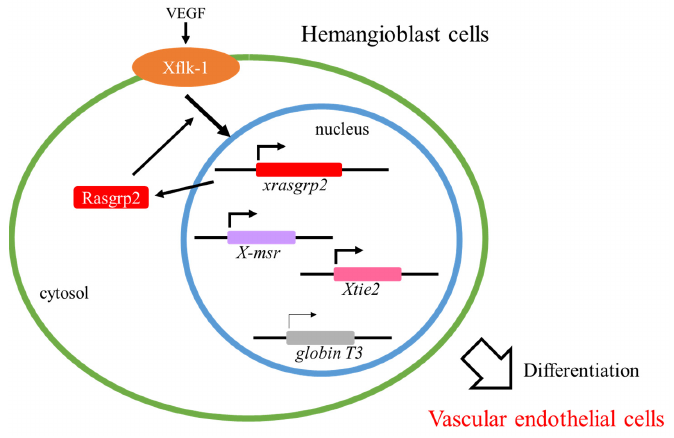
Figure 2. Proposed model for Rasgrp2 function in hemangioblast cells. VEGF: vascular endothelial growth factor, Rasgrp2: Ras guanyl nucleotide-releasing protein 2.